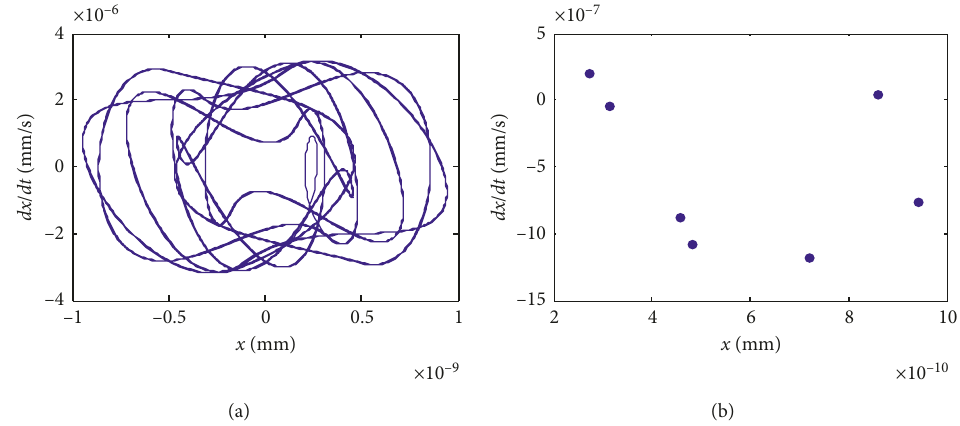
Figure 9: System response for ω � 10000r/min. (a) Phase portraits. (b) Poincar´e map.